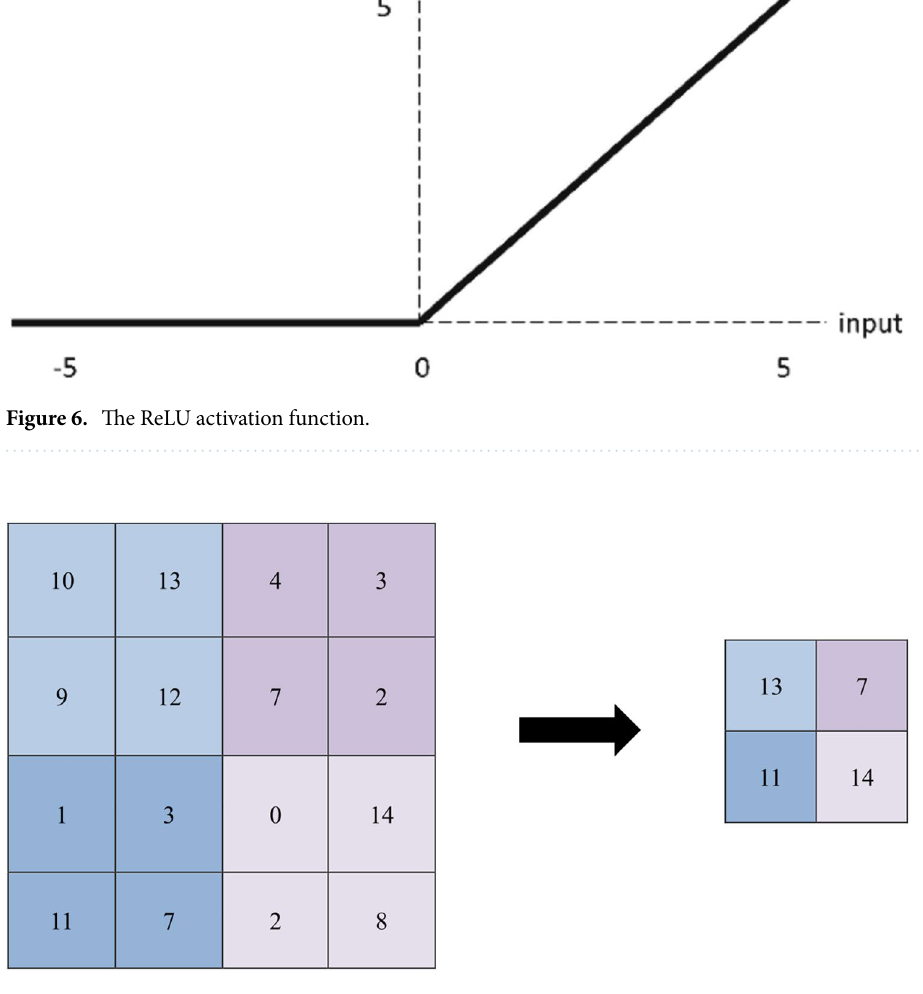
Figure 7. The output of max pooling for an image of size 4 × 4 pixels, a window of size 2 × 2 pixels, and a stride of 2 × 2